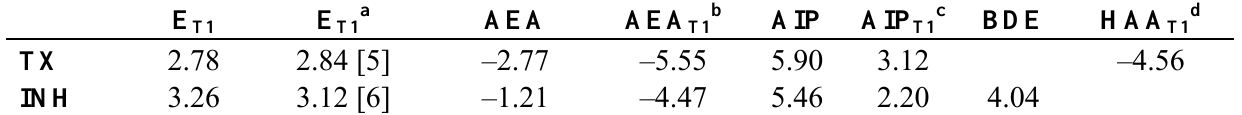
), adiabatic electron T1 ) 0